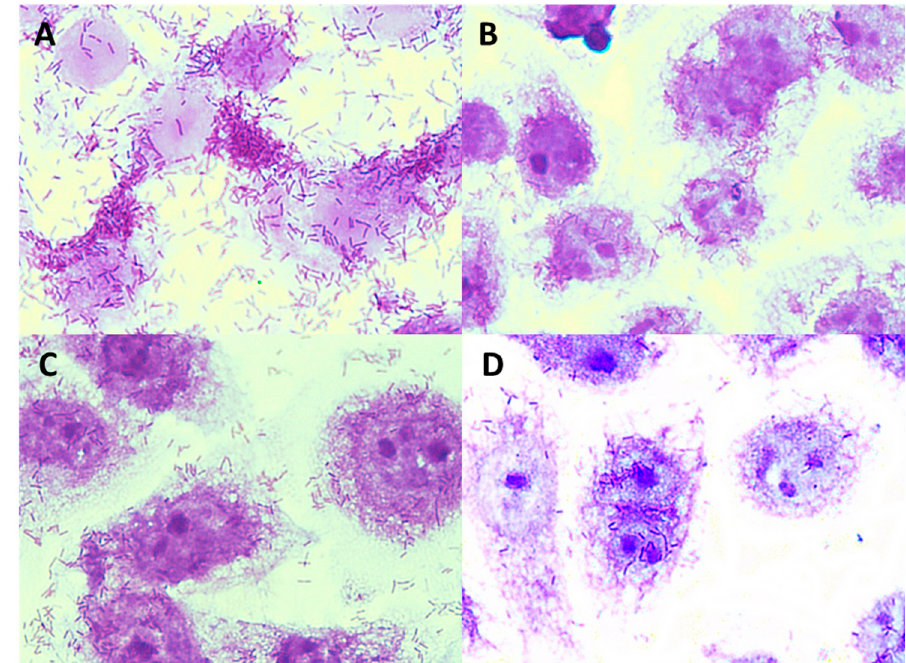
Figure 10. Microphotographs (magnification × 1000) showing adhesion of L. monocytogenes ATCC 19115 to Caco-2 cells in the presence and without apple pomace hydrolysates: ( A ) L. monocytogenes ATCC 19115, ( B ) L. monocytogenes ATCC 19115 + P1 preparation, ( C ) L. monocytogenes ATCC 19115 + P2 preparation, ( D ) L. monocytogenes ATCC 19115 + P3 preparation. Stained with 0.5% crystal violet.